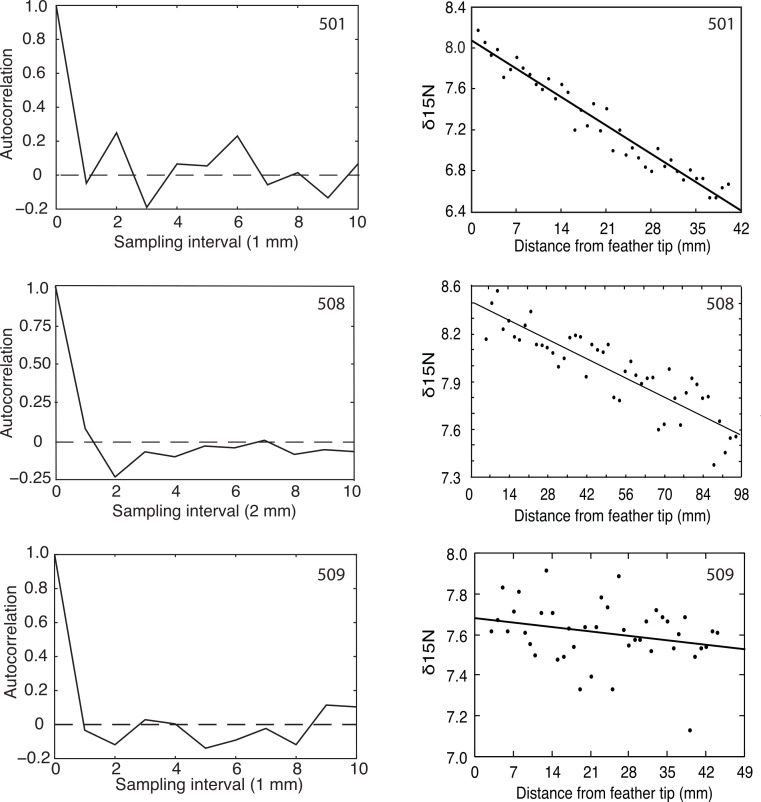
Autocorrelation and regression results for δ15N measured at 1 or 2 mm intervals from the tips of growing primaries.Greylag Geese 501 and 508 showed decreasing δ15N values, indicating they were equilibrating with the Saltholm isoscape while their primaries were growing, and both showed significant autocorrelations (p = 0.01 and 0.03, respectively). Goose 509 showed no change in its δ15N values and no autocorrelation (p > 0.25).